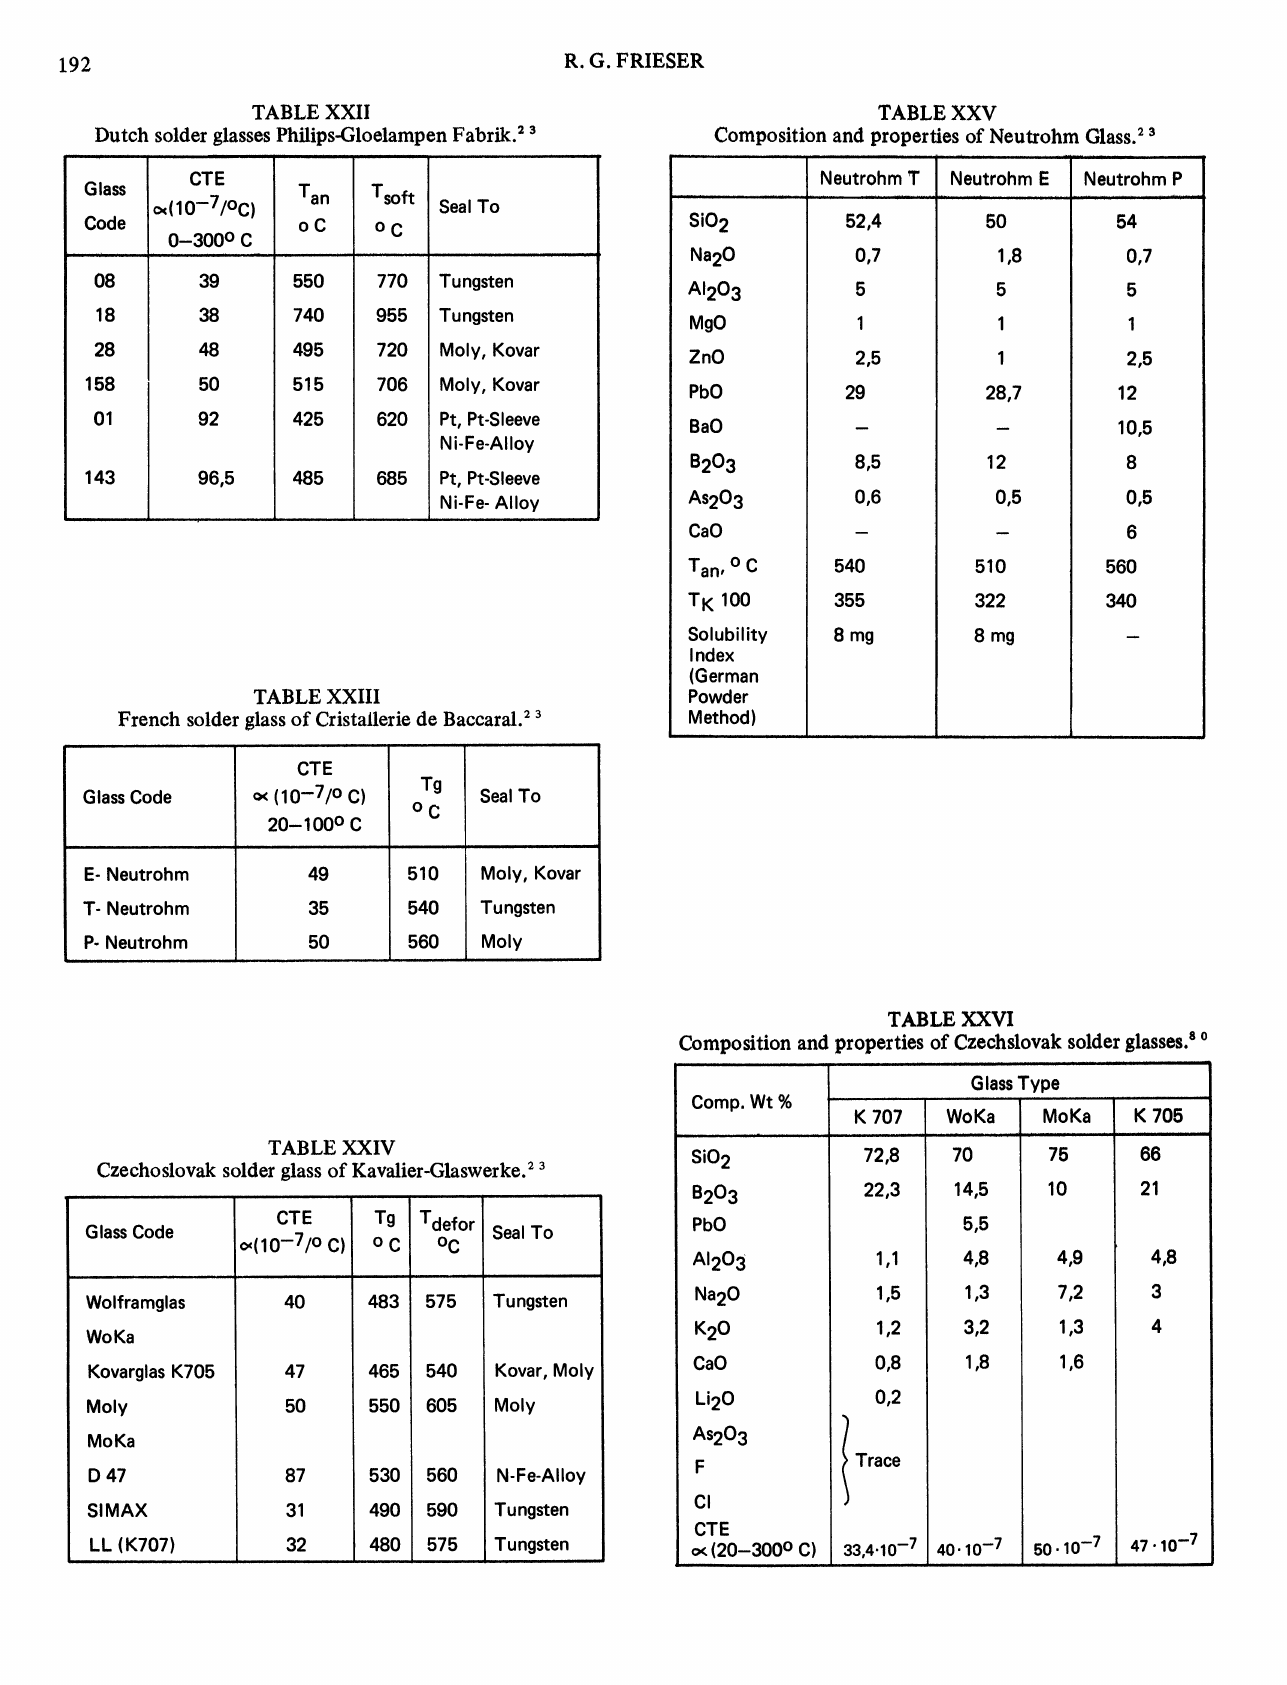
TABLE XXII Dutch solder glasses Philips-Gloelampen Fabrik.